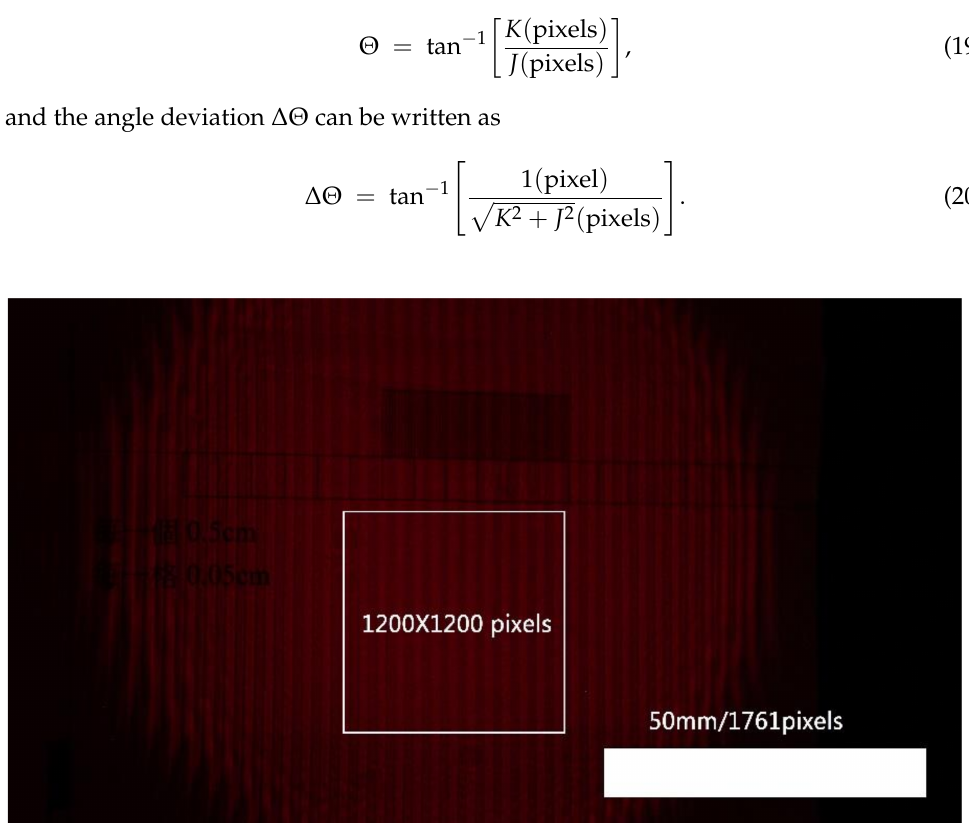
Figure 6. A digital image (5184 pixel × 2912 pixel) of captured pattern marked with scale bar and number of